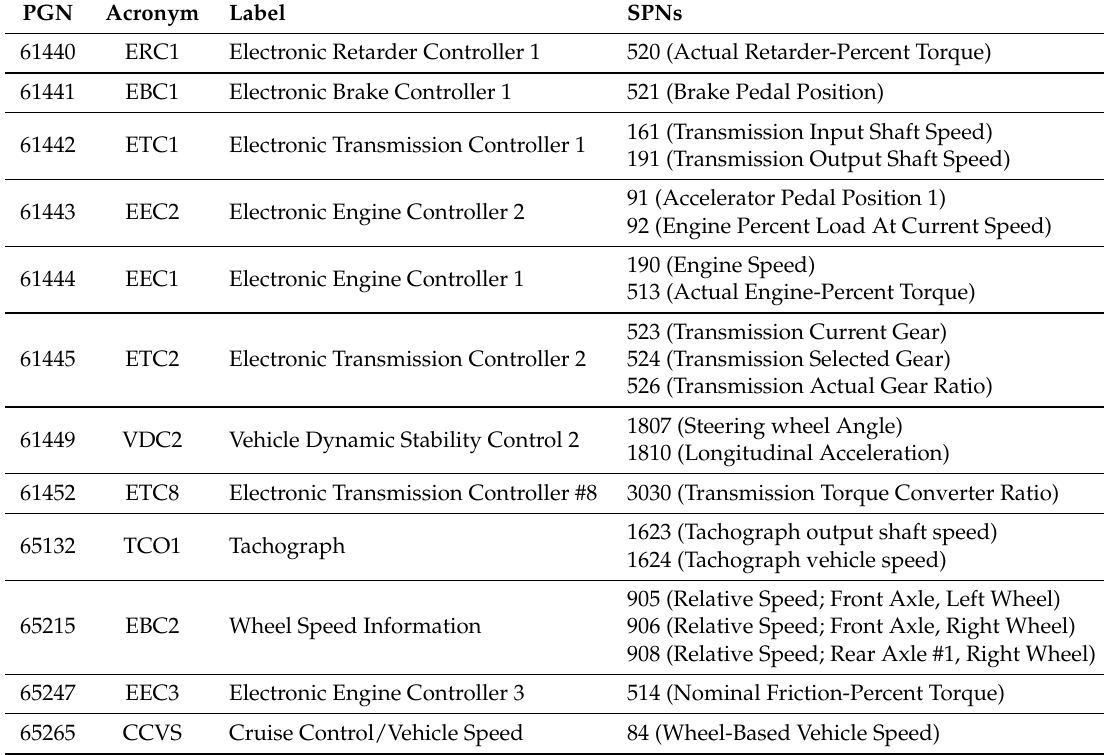
Table A1. Variables from CAN